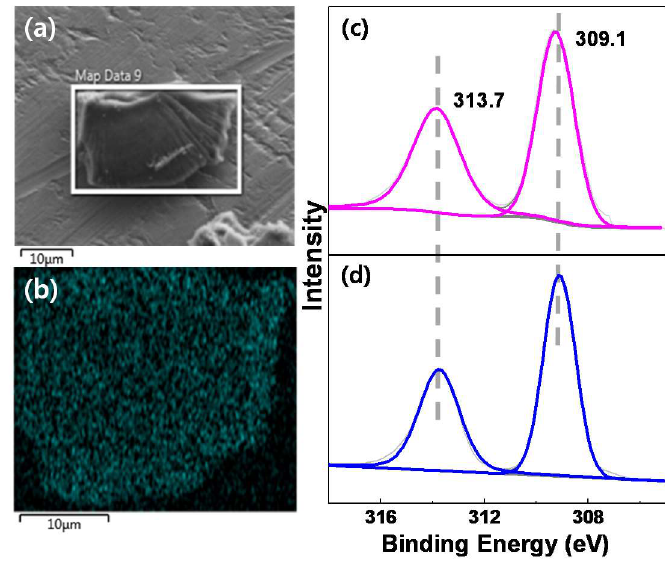
Figure 1. ( a ) SEM image of Rh 1.7 @bpy-CTF400 and ( b ) the corresponding EDS mapping of Rh. ( c , d